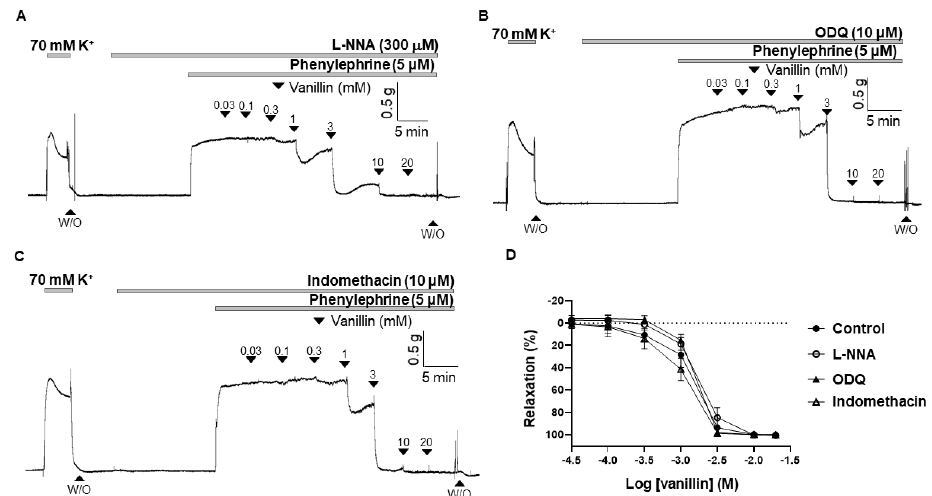
Figure 3. Effect of eNOS inhibitor (L-NNA), sGC inhibitor (ODQ), and COX inhibitor (indomethacin) on vanillin-induced vasodilation. Representative trace showing vanillin-induced vascular relaxation in the presence of L-NNA ( A ), ODQ ( B ), and indomethacin ( C ). Statistical analysis of the vasodilation in response to vanillin in the presence of L-NNA, ODQ and indomethacin ( D ). Relaxation is expressed as the percentage of the contraction induced by PE (5 µM). Mean ± SD ( n = 5). (L-NNA: N ω -Nitro-L-arginine; ODQ: 1H-[1,2,4]-oxadiazolo-[4,3- α ]-quinoxalin-1-one; W/O: wash out).